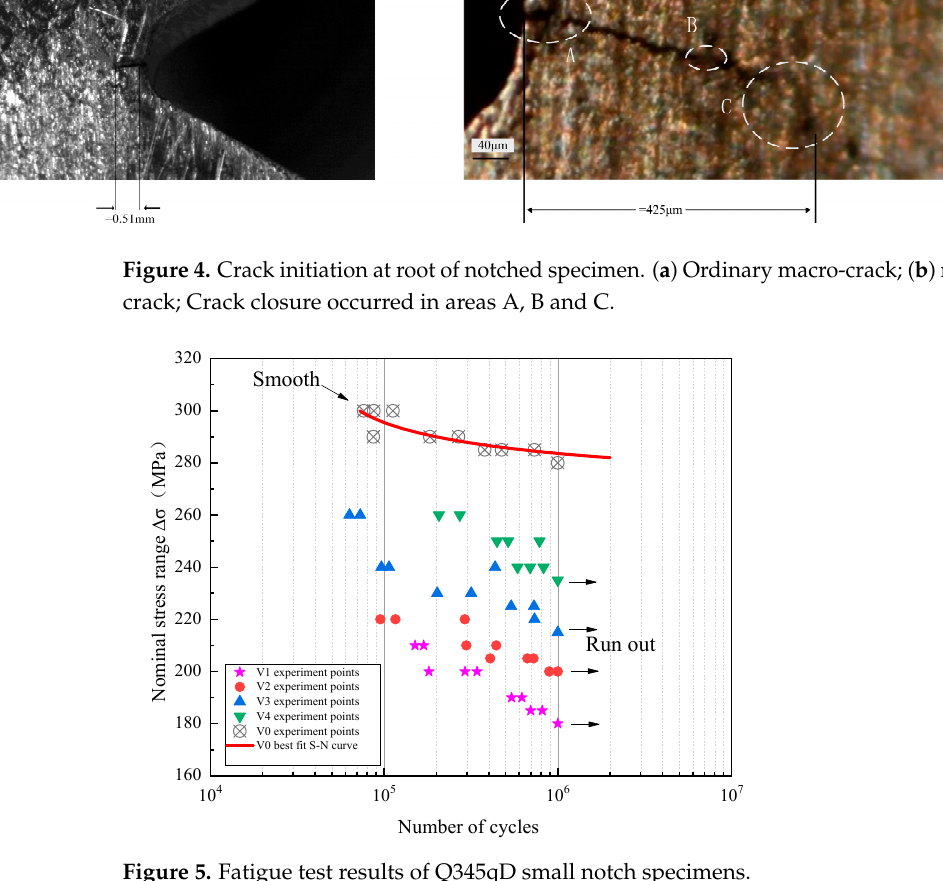
Figure 5. Fatigue test results of Q345qD small notch specimens.